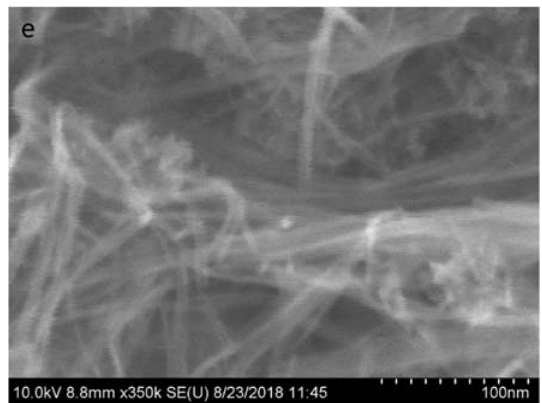
Figure 2. Scanning electron microscopy (SEM) images of Mn 3 O 4 synthesized at different temperatures for 4h ( a ) commercial Mn 3 O 4 ; ( b ) 170; ( c ) 150; ( d ) 130; ( e ) 110 °C. Table 1. BET surface area of Mn 3 O 4 .